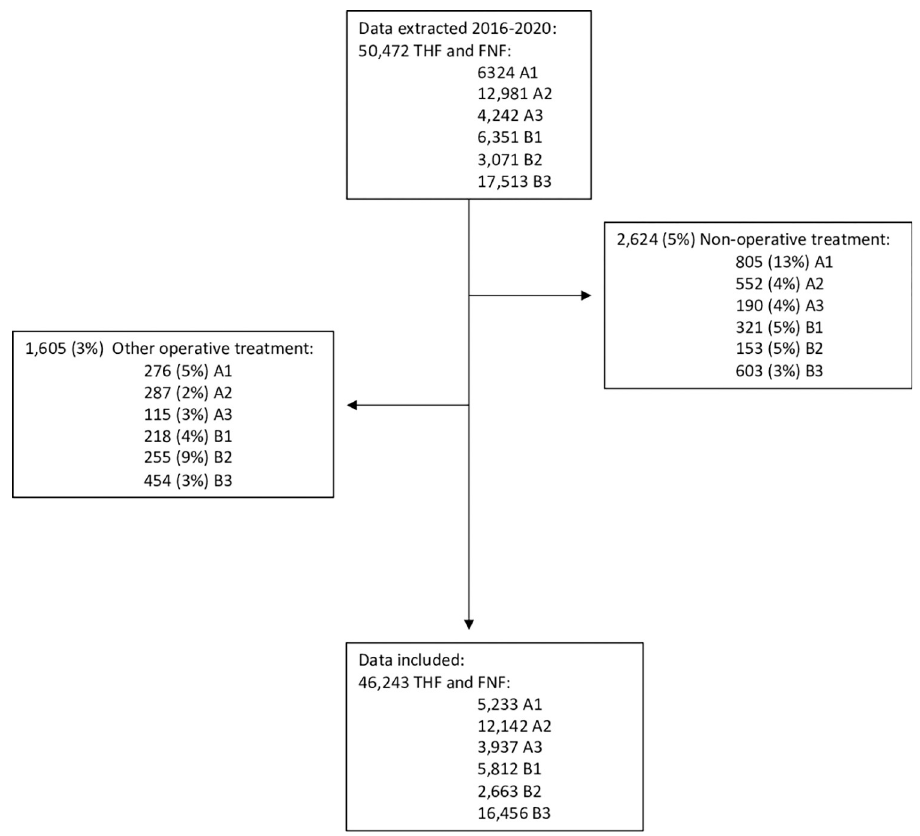
Fig 1. Flowchart showing patient selection. 46,243 patients � 65 years registered in the SFR with a trochanteric hip fracture (THF) treated with a sliding hip device or an intramedullary nail or femoral neck fracture (FNF) treated with internal fixation or arthroplasty in